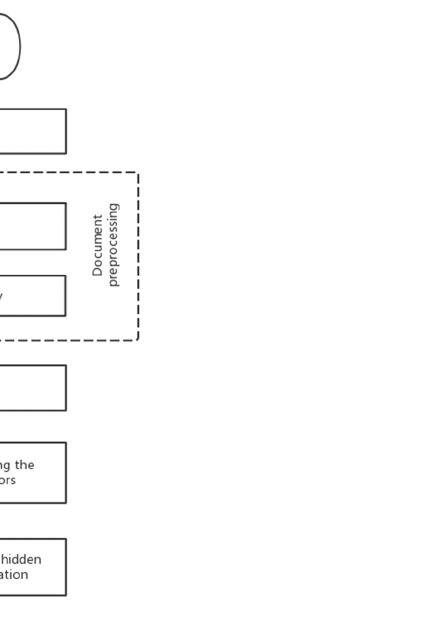
Figure 2. Word cloud of important words related to hidden danger factors of electric power per- sonal casualty accidents. casualty